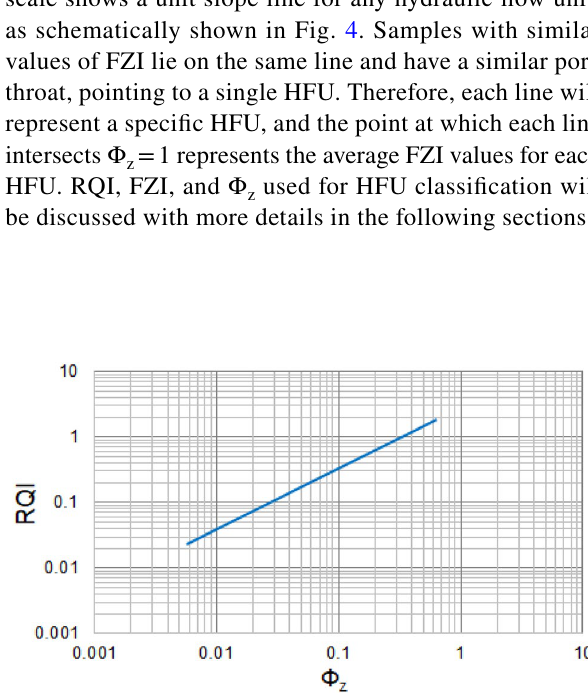
Fig. 4 A schematic plot for RQI vs. Φ